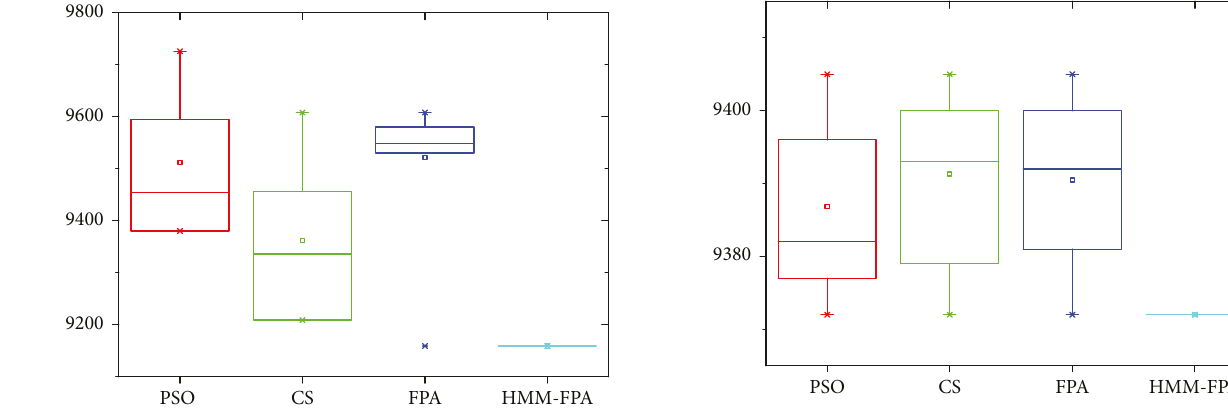
Figure 11: ANOVA tests of